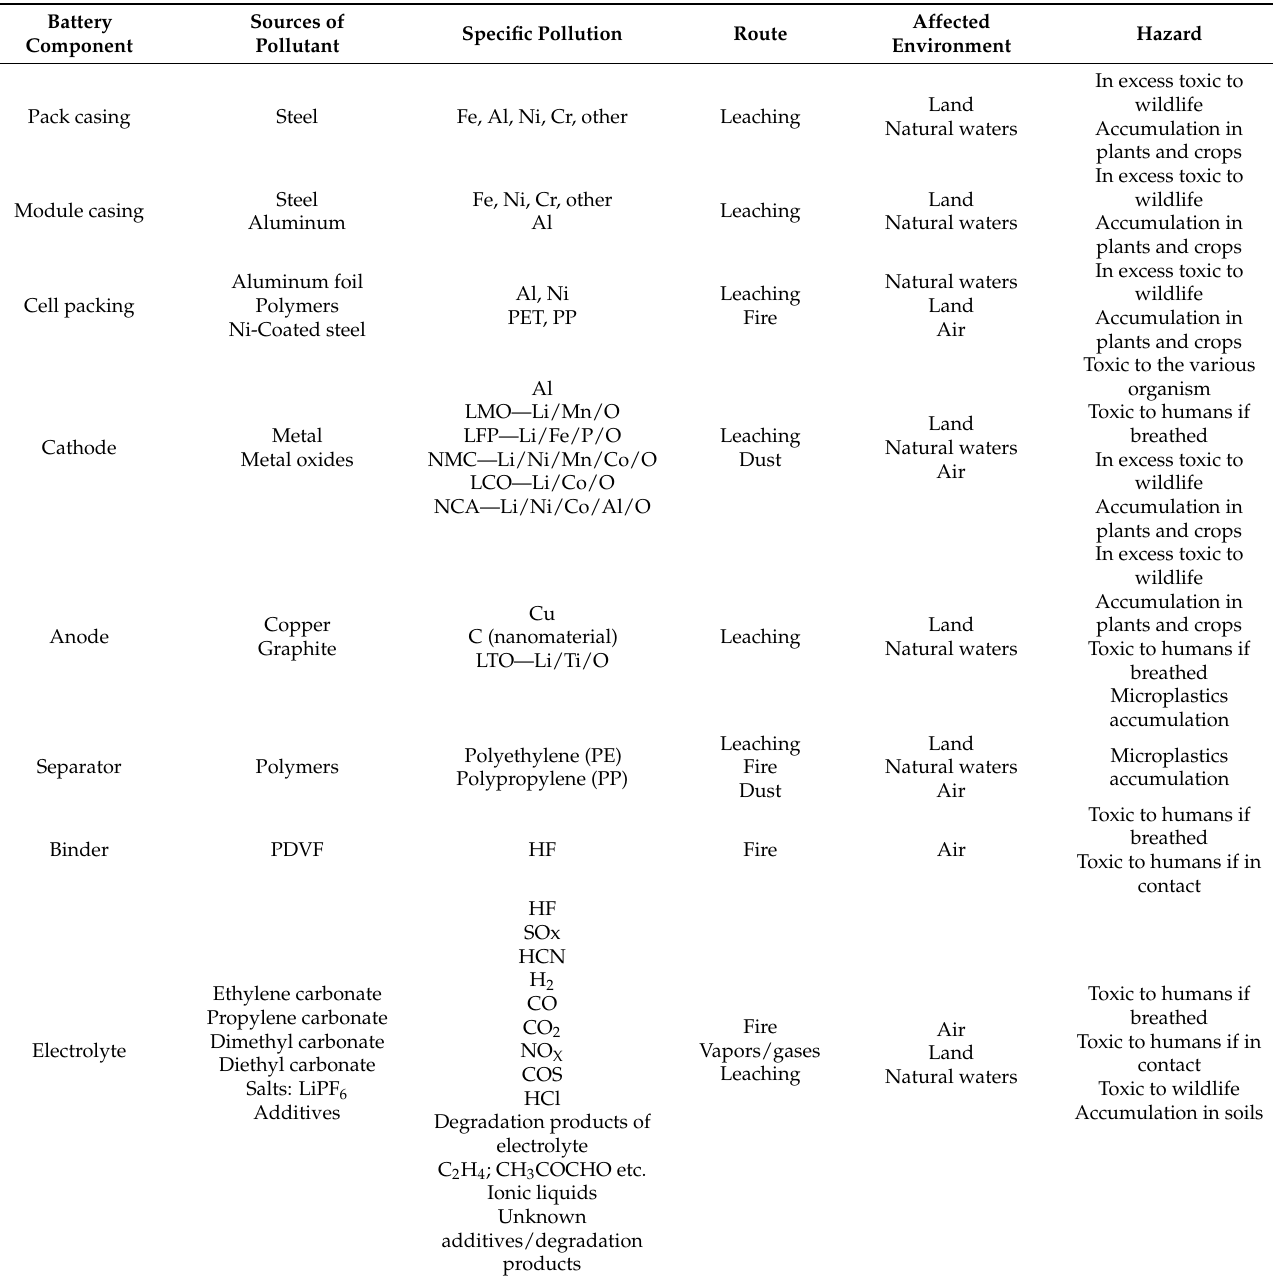
Table 4. Overall LIB compositions and pollutant emissions